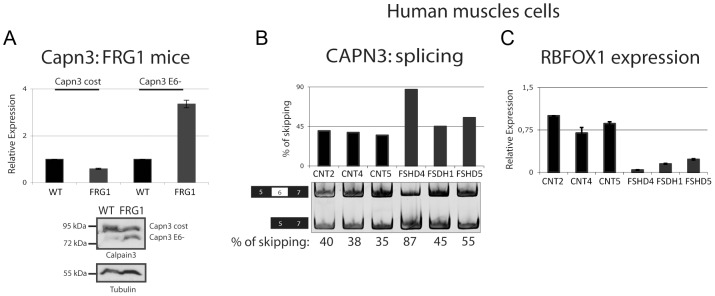
Alternative splicing isoform of Calpain 3 increased in FRG1 mice and in FSHD patients.(a) Real-time RT-PCR and immunoblotting analysis confirming that the Capn3 alternative splicing isoform lacking exon 6 (Capn3 E6-) is increased in the vastus lateralis muscle from FRG1 mice. (b) RT-PCR analysis of CAPN3 splicing in human muscle cells derived from three different healthy subjects and three different FSHD patients indicates increased expression of CAPN3 E6- isoform in FSHD patients. Numbers below the image are the percentage of exon skipping. Black boxes illustrate constitutive exons, white boxes alternatively spliced exon. RT-PCR products were quantified using the Typhoon. (c) RBFOX1 expression analysis was performed on RNA extracted from the same samples as in (b) by real-time RT-PCR.